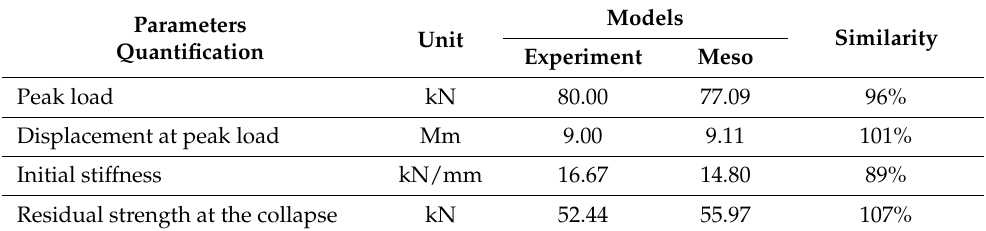
Table 7. Validation results for infilled frame meso model vs experiment.